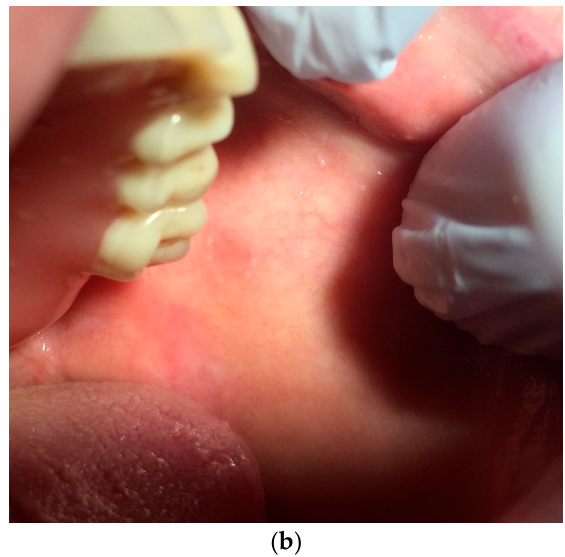
Figure 6. ( a ): Mucosa of the left cheek of a patient affected by leucoplakia right after the removal of stitches positioned after biopsy sampling. ( b ): Same area three weeks after laser treatment.